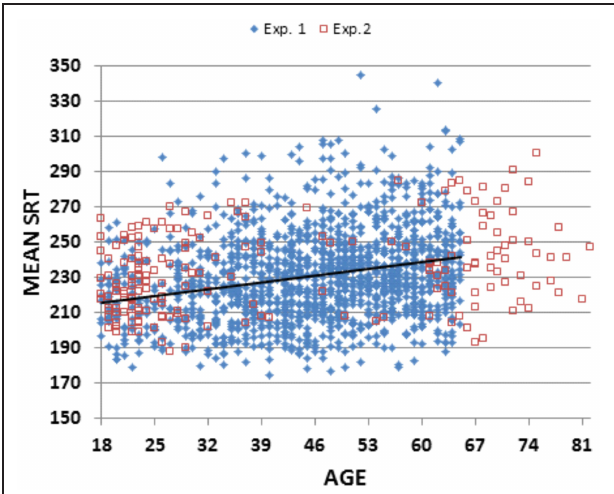
FIGURE 2 | Simple reaction times (SRTs) as a function of age. From subjects in Experiment 1 (blue diamonds) and Experiment 2 (open red squares). Eight subjects from Experiment 1 with mean SRTs above 350 ms are not shown. The linear trend line is from Experiment 1 data.